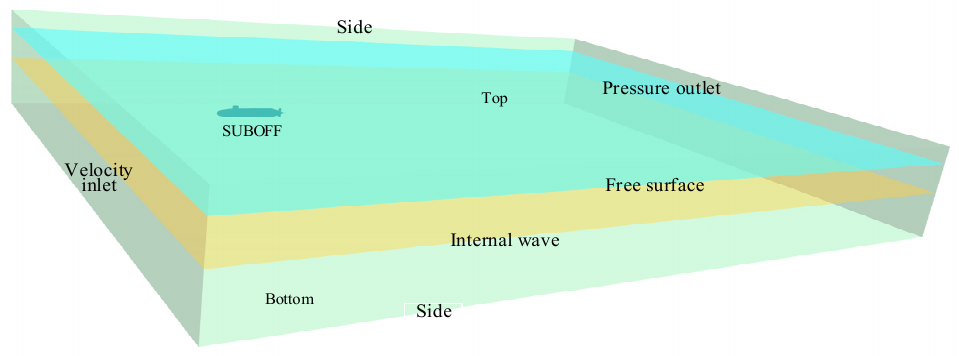
Figure 6. Computational domain and hull boundary conditions.